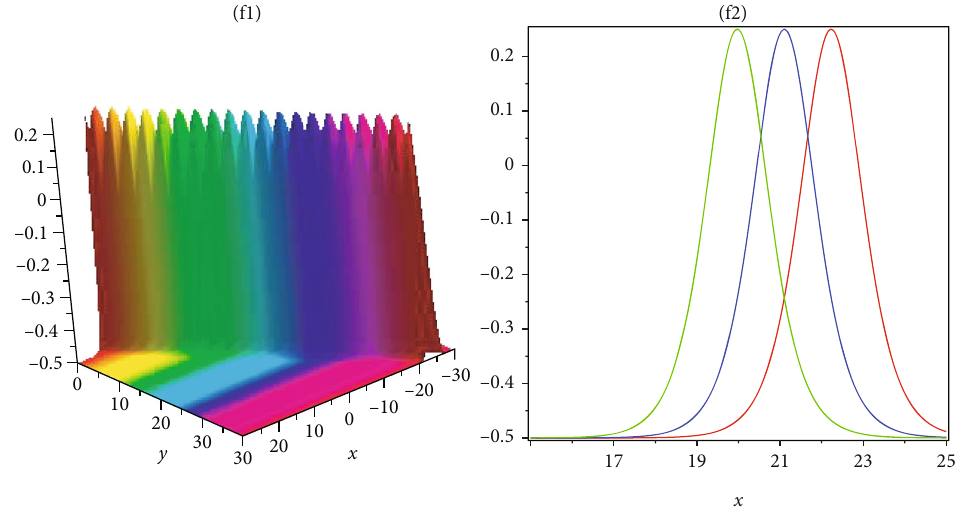
Figure 2: Graph of Eq. (22) for the ( 2 + 1 )-dimensional Benjamin-Ono equation at a = 2, α = 2, β = − 3, c = 2, γ = 2, r = 1, w = 0 : 3, t = 20 and for 2 plot spaces y = − 1, 0, 1